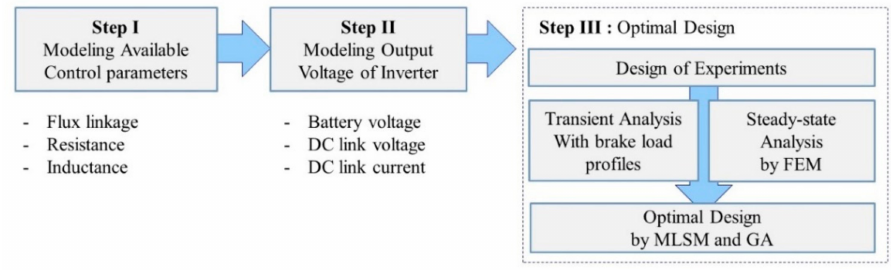
Figure 1. Optimal design strategy for the BLAC motor in an integrated brake